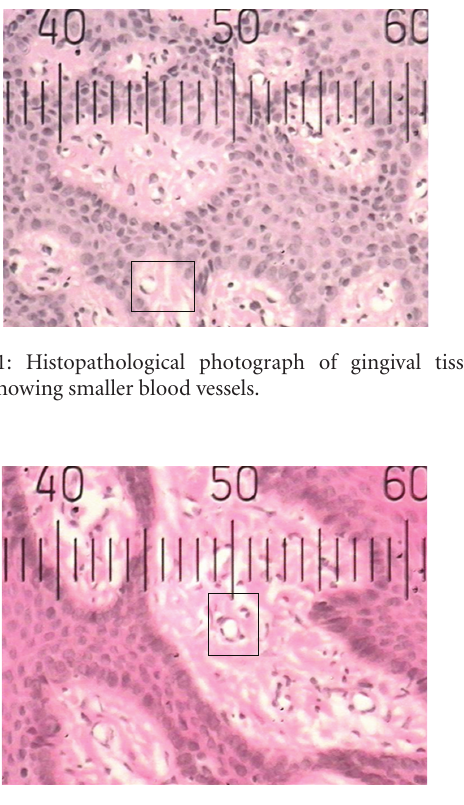
Figure 2: Histopathological photograph of gingival tissue in nonsmoker showing smaller blood